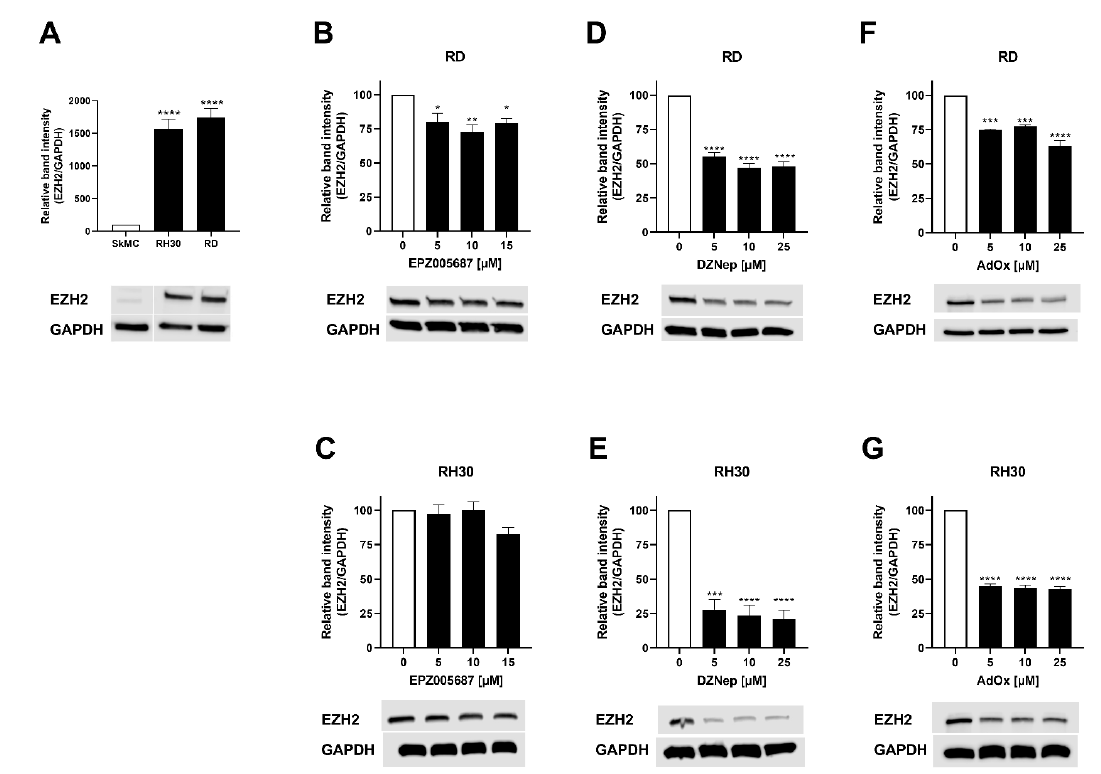
Figure 1. EZH2 abundance in RMS cell lines in the presence or absence of EZH2 inhibitors. ( A ) Representative Western blot of EZH2 and densitometric quantification of SkMC, RD, and RH30 cells. Relative ratio of EZH2/GAPDH density was normalized to ratio obtained in SkMC. Effect of EPZ005687 ( B , C ), DZNep ( D , E ), and AdOx ( F , G ) on RD (upper row) and RH30 cells (lower row) on EZH2 abundance. Relative ratio of EZH2/GAPDH density was normalized to ratio obtained in untreated control cultures. GAPDH was used as loading control. Error bars represent mean +/ − SEM ( n = 3). p * ≤ 0.05, p ** ≤ 0.01, p *** ≤ 0.001, p **** ≤ 0.0001 indicates statistical significance.